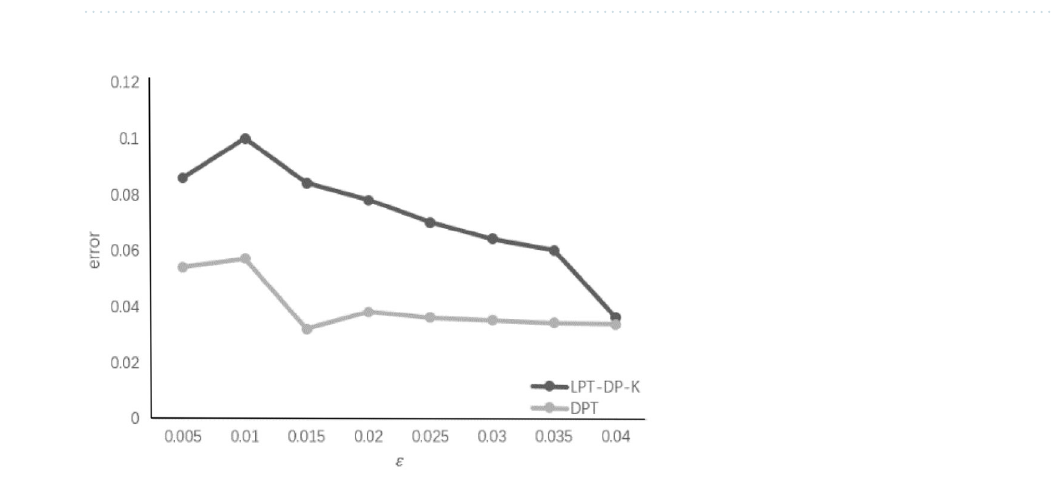
Figure 5. K value on data loss rate.